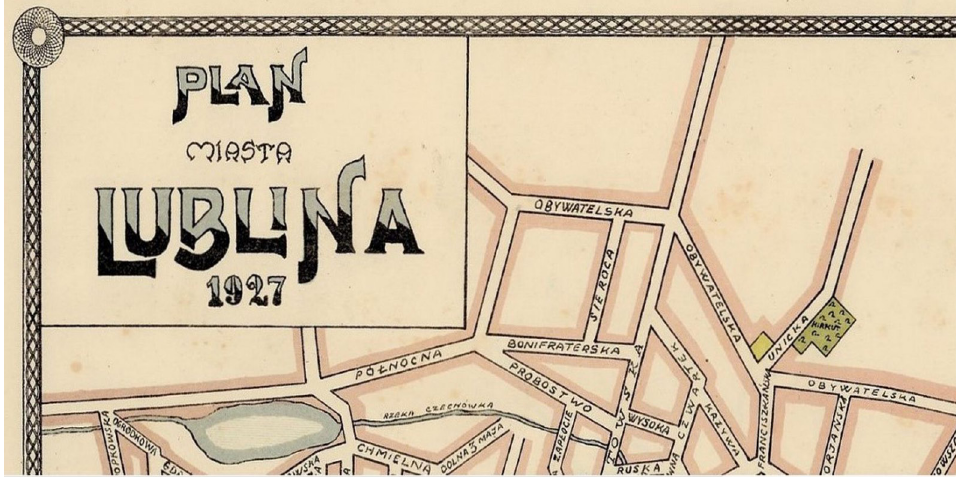
Fig. 2. Północna Street on the city map of Lublin, 1927